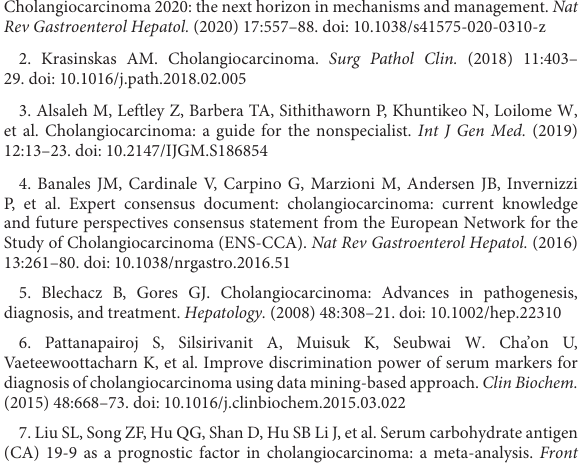
SUPPLEMENTARYTABLE4 The correlation coefficient between variables. SUPPLEMENTARYTABLE5 The tolerance and variance inflation factor (VIF) values of each